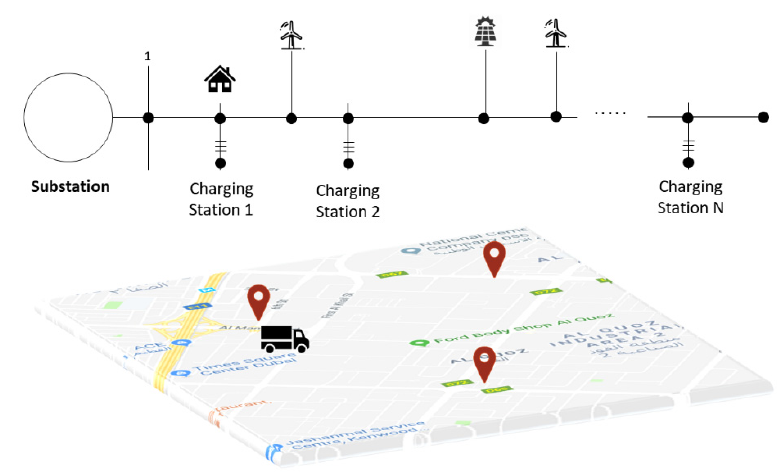
Figure 1. Distribution system with multiple PLs.